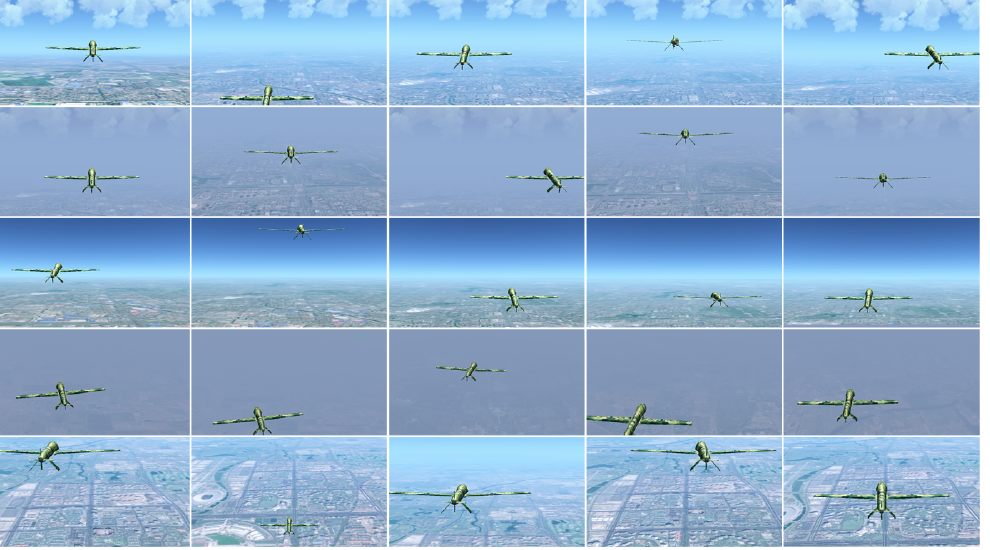
Figure 10. Aircraft attitude measurement